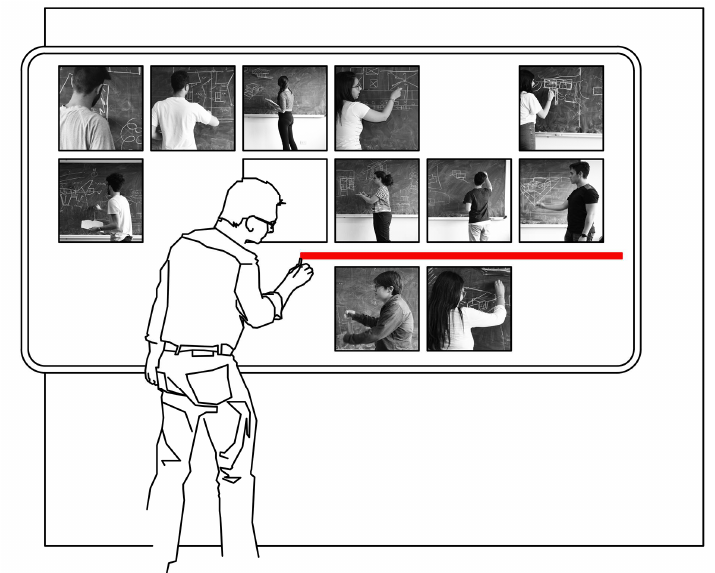
Figure 2. Images of students invited to describe architectures using sketches (photographic processing and design by tutor Giuseppe